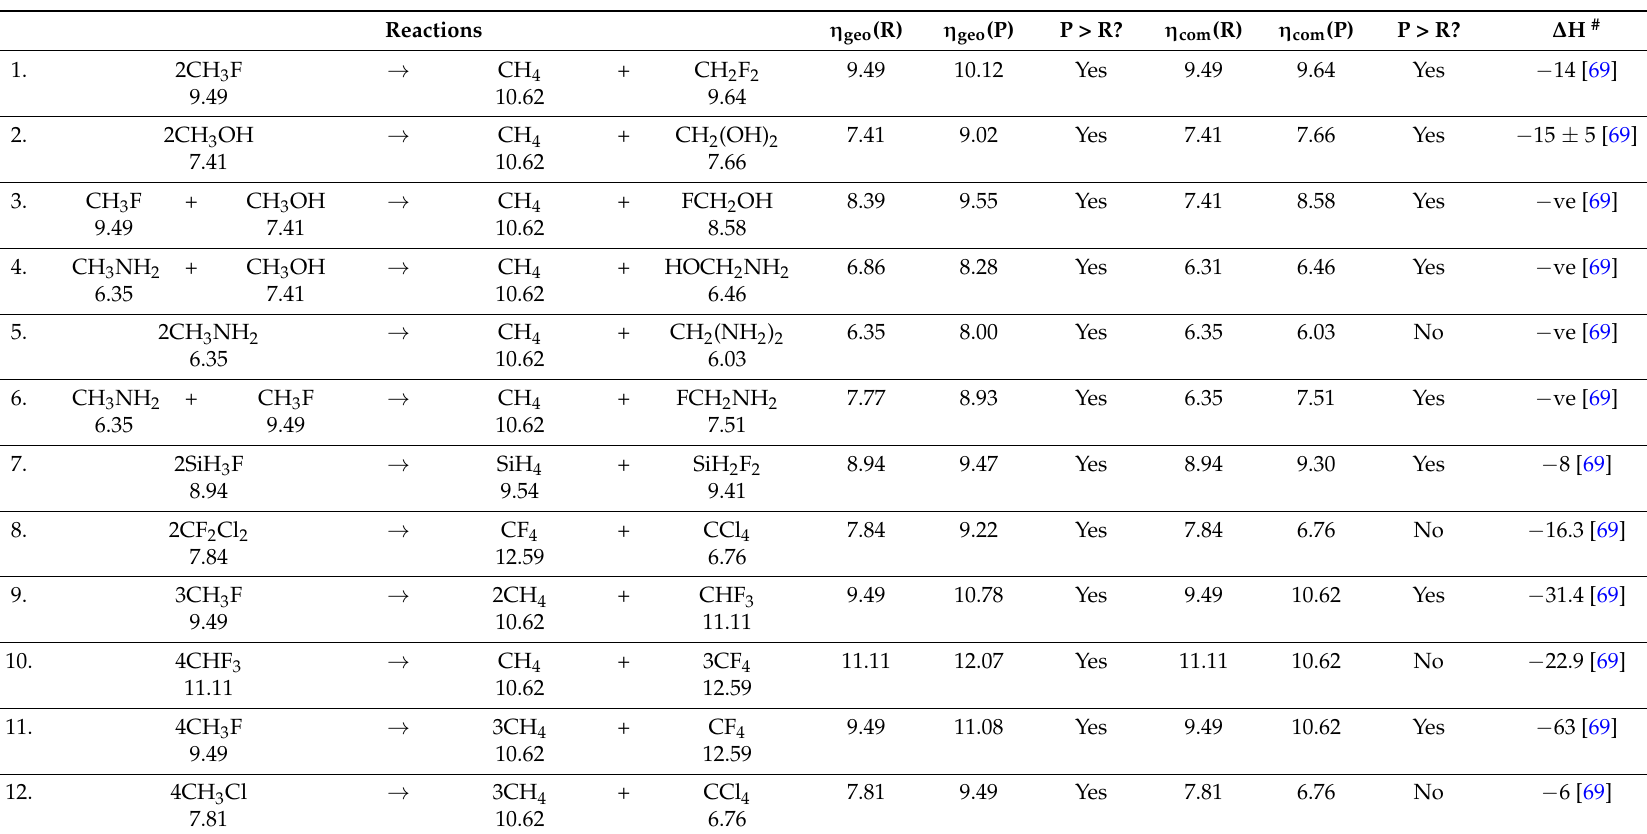
Table 1. Hardness ( η , eV) values of the individual reactants and products, geometric mean ( η geo , eV) of the hardness values and combined hardness values ( η com , eV) for the reactant and product sides at the B3LYP/6-311++G(2df,3pd)/def2-QZVP (def2-QZVP for iodine and Hg) level for the chemical reactions. The enthalpy changes ( ∆ H) for the reactions are in